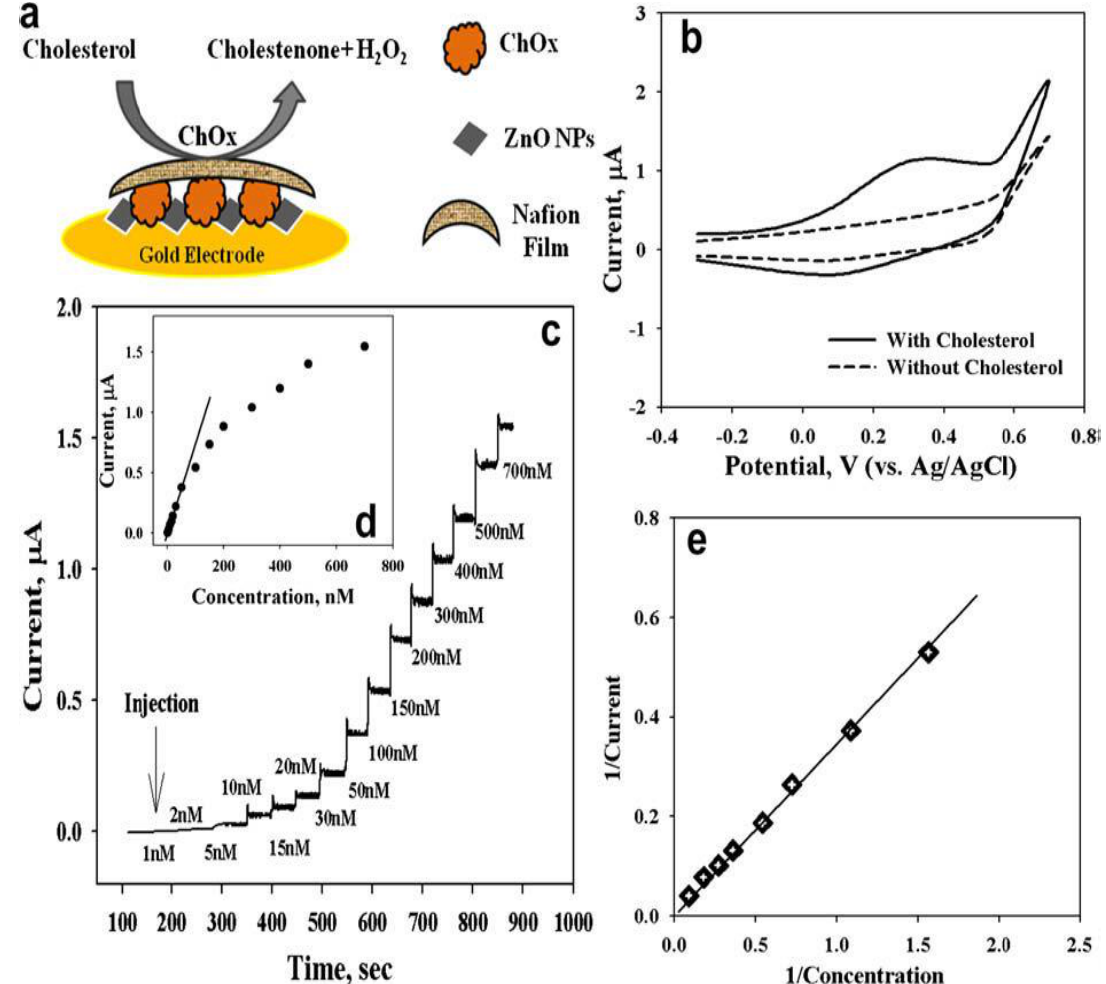
Figure 6. ( a ) Illustration of the cholesterol-sensing mechanism of conductive electrode/ZnO nanoparticles/Chox/Nafion(modified transducer) for enhancing their biosensor performance; ( b ) electrochemical analysis based on current vs. voltage plot for the modified transducer, solid line refers to the system exposed to cholesterol, and the dotted line without cholesterol, in phosphate-buffered saline solution; ( c ) current response time of the modified transducer when exposed to cholesterol with addition of phosphate-buffered saline; ( d ) graph curve for different cholesterol concentrations as a function of magnitude of current using a modified transducer; and ( e ) the plot of 1 / current vs. 1 / concentration, where a direct relationship with the cholesterol concentration and steady-state current is shown. Reprinted from [70]. Copyright 2009, with permission from Elsevier. Table 1. Different techniques of 0-D ZnO-based electrochemical biosensors for various analyte detections, since 2014.